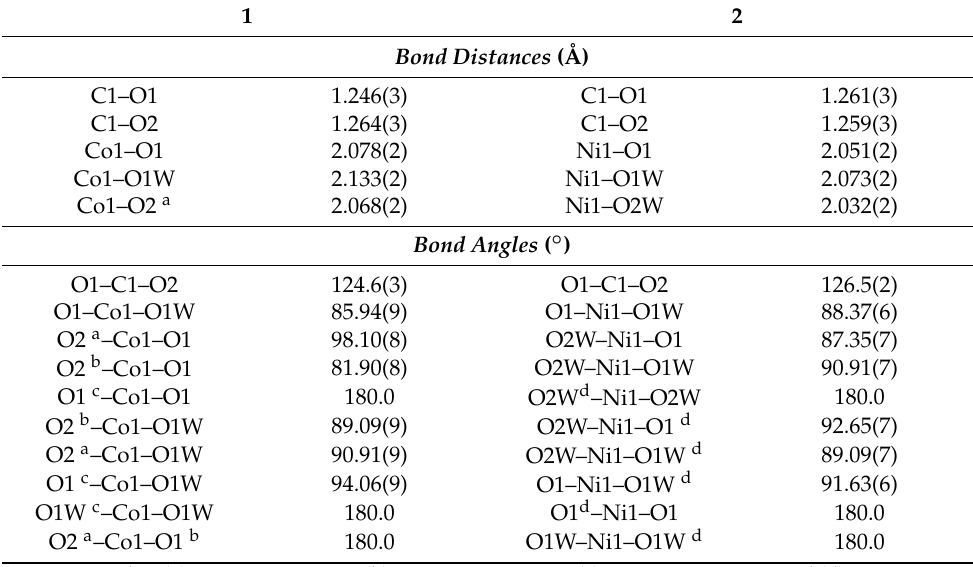
Table 2. Selected bond distances and angles in 1 and 2 .